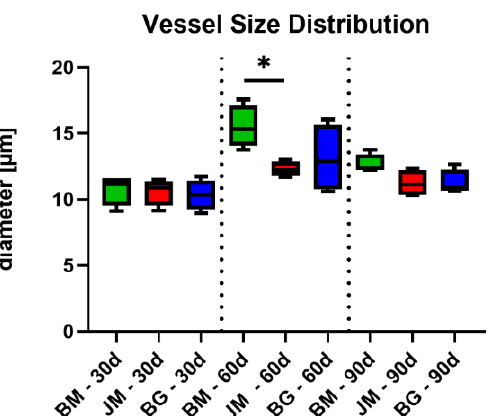
Figure 18. Results of the histomorphometrical measurements of the vessel sizes within the membrane areas (* = intraindividual differences; *: p < 0.05). BM: bovine membrane, JM: Jason ® membrane, BG: Bio-Gide ® .